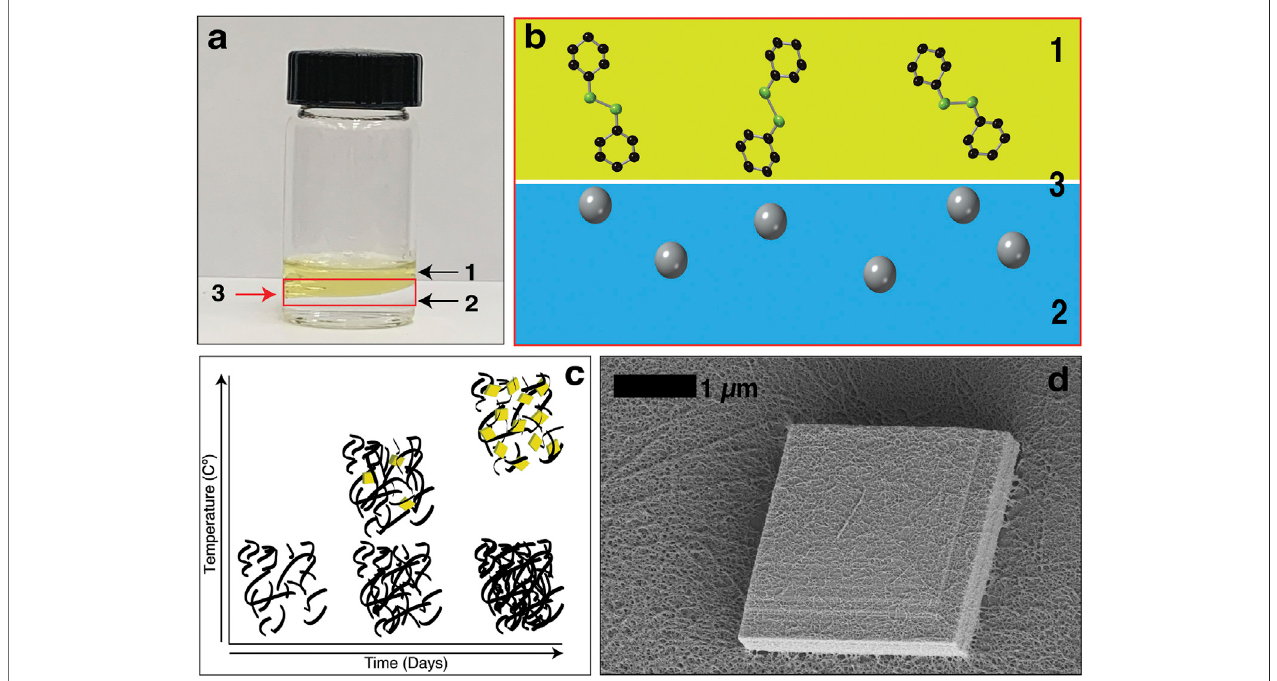
FIGURE 1| (A) An image of the interfacial synthesis of mithrene. Where (1) isthe diphenyl diselenide in toluene layer, (2) isthe aqueous silver nitrate layer, and (3) is theoil-waterinterface. (B) Diphenyl diselenide molecules andthesilverionsintheaqueous solutionattheinterface. (C) Agraphshowingthattemperature controlduring the interfacial synthesis can be used to isolate the kinetic and thermodynamic products. (D) Scanning electron micrograph of a single mithrene microcrystal, where the layered structure is evident, and the amorphous polymer presence is on the surface of the microcrystal.